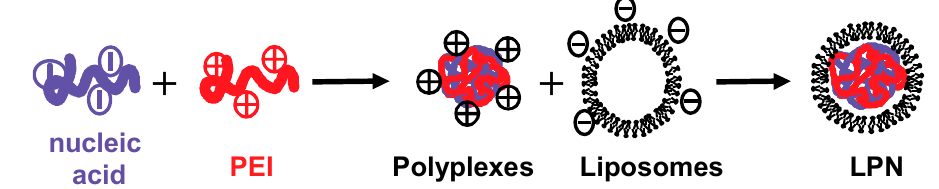
Figure 1. Two-step preparation of liposome polymer nucleic acid (LPN).